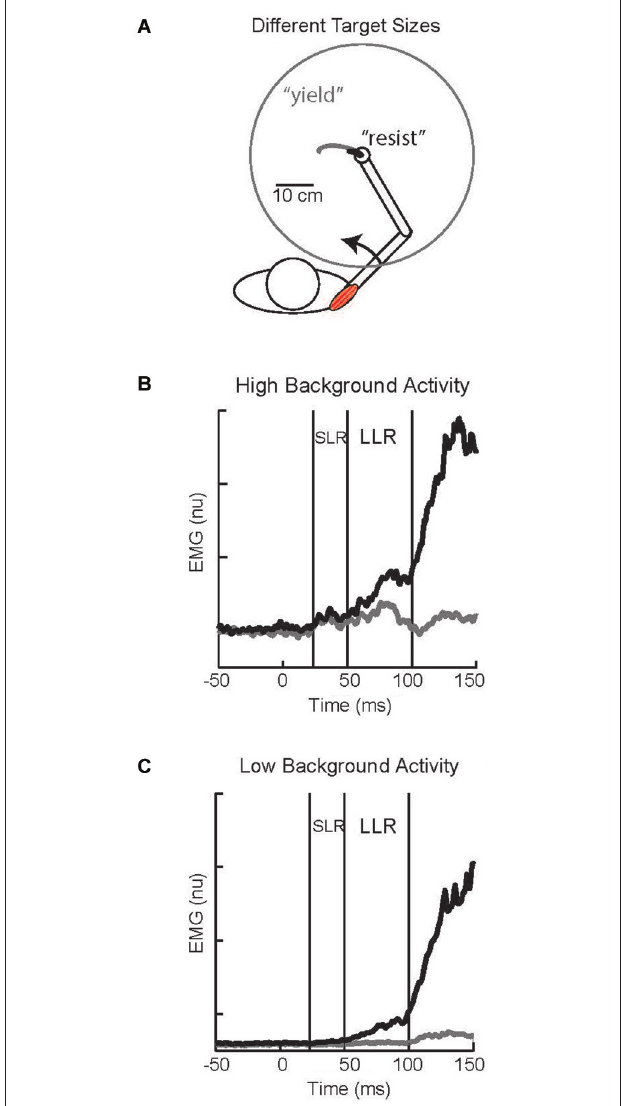
FIGURE 6 | Task-dependent change in LLR. (A) Cartoon of subject responding to an imposed shoulder torque. Maintaining the hand within a small target requires a vigorous response and is analogous to a “resist” instruction; the black trace depicts the small displacement of the hand to the perturbation. Maintaining the hand within a large target requires a weak response and is analogous to a “yield” instruction; the gray trace depicts the large displacement of the hand to the perturbation. (B) Evoked shoulder activity while the muscle had a high level of background activity from countering a constant opposing load; black and gray traces correspond to the small and large target conditions, respectively. (C) Evoked shoulder activity while the muscle had a low level of background activity as its antagonist countered a constant opposing load. Figure modified with permission from Kurtzer et al.